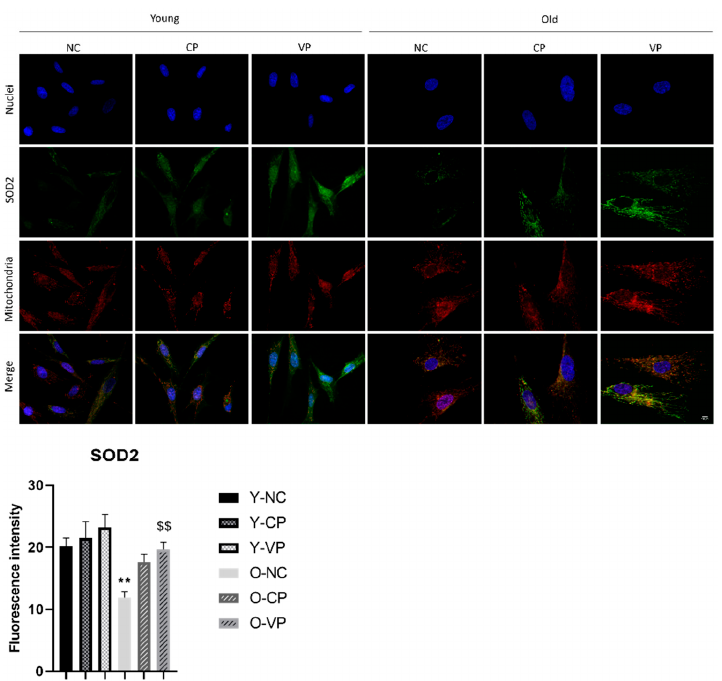
Figure 4. Double immunolabeling for SOD2 protein (green fluorescence) and mitochondria (red fluorescence); DNA was stained with Hoechst 33258 (blue fluorescence). Magnification: 60×; scale bar: 10 μ m. Histograms representing the analysis of the fluorescence intensity of SOD2; Anova one-way test: p = 0.02; ** p < 0.01, statistical significance between untreated young NHDF (Y-NC) and old untreated NHDF (O-NC); $$ p < 0.01, statistical significance between old NHDF treated with VP and old NHDF untreated.